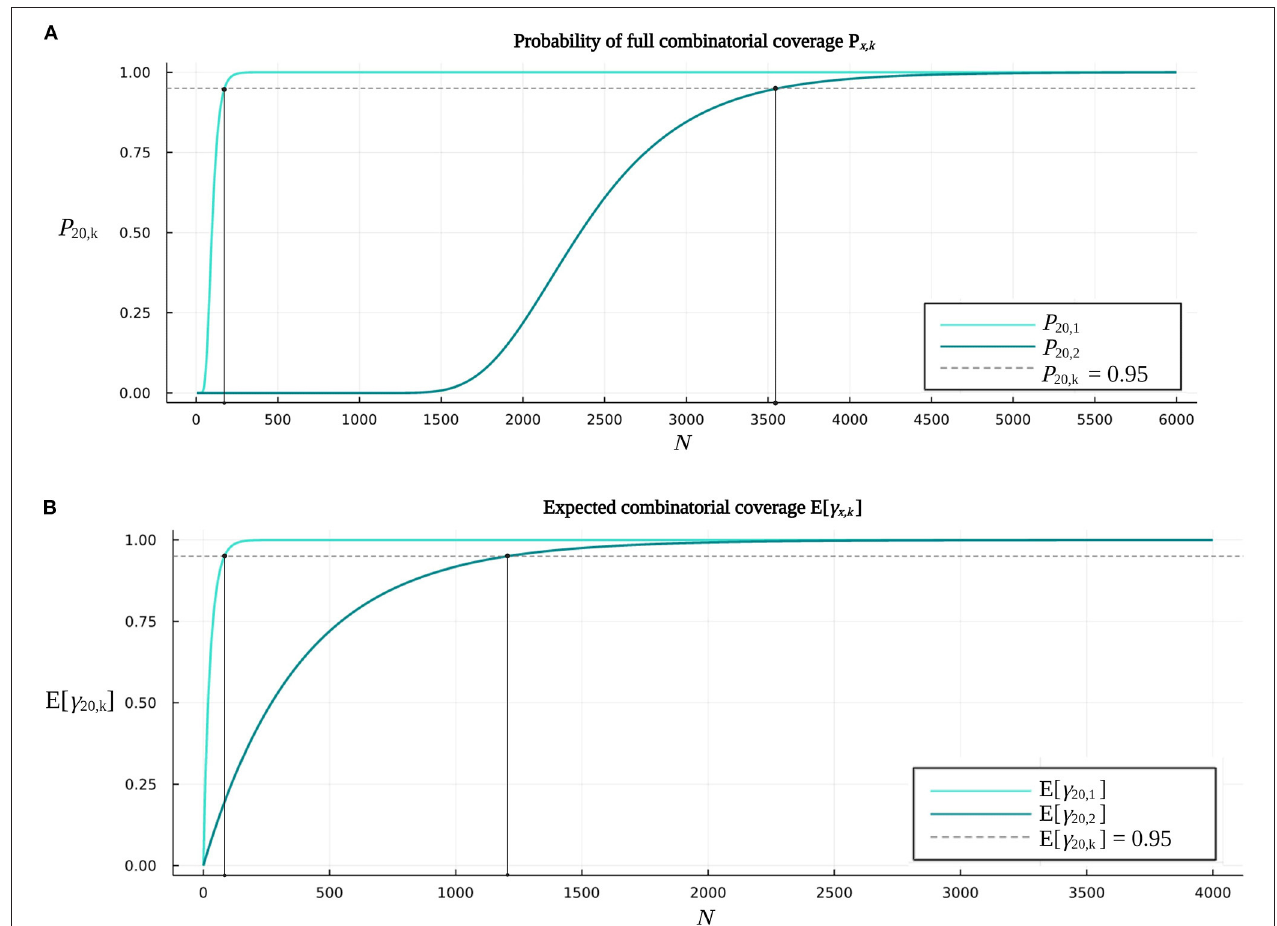
FIGURE 6 | Additional functionalities provided by BioCCP to gain insight into the coverage of multiplex CRISPR/Cas screens. (A) The probability of full coverage P 20, k w.r.t. the plant library size N of a (multiplex) CRISPR/Cas screen. The graph P 20,1 indicates the probability of full coverage of all single gene knockouts for an increasing number of plants in the plant library. Parameter settings of the CRISPR/Cas screen are specified by Table 2 ( k = 1). The graph P 20,2 quantifies the probability of full coverage of all (cid:0) 20 pairwise combinations of gene knockouts w.r.t. the plant library size. A multiplex CRISPR/Cas screen as specified by the parameter settings in 2 (cid:1) Table 2 is considered ( k = 2). (B) Expected coverage of all single gene knockouts (E[ γ 20,1 ]) and pairwise combinations of gene knockouts (E[ γ 20,2 ]) w.r.t. the plant library size of a (multiplex) CRISPR/Cas screen. Parameters of the experiments correspond to the default settings as specified in Table 2